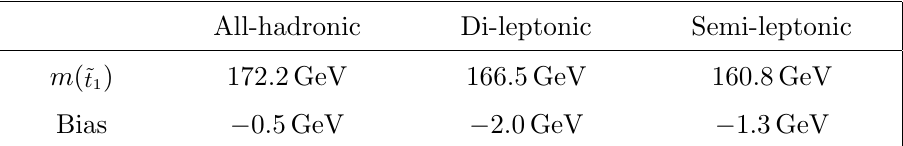
Table 1 . Summary of the maximum bias on the measured m t due to stop contamination in each channel, assuming m ( ~ (cid:31) 0 1 ) = 1 GeV. The top row shows the mass of the stop that maximally biases the experimentally measured mass from the Monte Carlo truth mass. The size of the bias in the Figure 1: Diagrams representing the four main signals targeted by the analyses: (a) the decay of the top squark measurement for each channel is shown in the bottom b ˜  ± via the lightest chargino (˜ t ), (b) the two-body decay into an on-shell top quark and the lightest neutralino 1 ! (˜ t t ˜  0 ), (c) the three-body decay mode into an on-shell W boson, a b -quark and the lightest neutralino (˜ t 1 ! ˜  0 b f f and (d) the four-body decay mode (˜ t ) where the two fermions f and f 0 are a lepton with its neutrino in 0 1 !